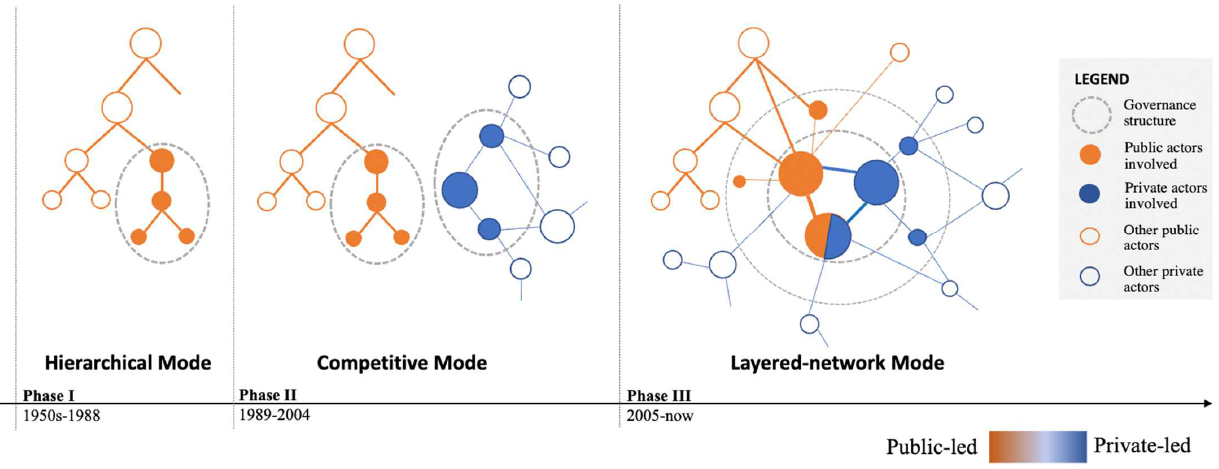
Figure 11. Changes of governance structures in the MRN. Source: the authors. The horizontal and vertical embedding of rights’ holders has changed. In terms of vertical reorganization, the three federal states have transferred some of their financial and administrative powers within the MRN, simplifying the vertical structure of cross- regional governance. In particular, the centralization of planning and approval powers has realized the vertical transmission of plans, policies, and major projects. In addition, the Verband directly represents the region in regional development programs at the European level. It has not only established a “European department” that is in regular contact with the European Commission and its representatives but has also launched a major EU cross-border cooperation project (Interreg CODE24). In 2015, it became the home of the first European grouping of territorial cooperation in Germany. In terms of horizontal power interactions, the MRN has innovatively adopted a “strategic-operative” two-tier governance network to coordinate joint decision-making between multiple actors. At the strategic level, the Association for Future Development is at the core of the network, which unites other associations and alliances in the region to create a long-term platform for strategic dialogue in the context of local policies, reducing government regulations, pro- moting friendly competition in economic development, and giving full play to the initia- tives of the private sector. However, the pursuit of a balancing model at the regional level has been argued as producing inefficient decision-making processes and outcomes: “A balancing model that the regional association follows… sometimes the whole thing is not so effective” (Mr. S_City-level, Pos. 20), and